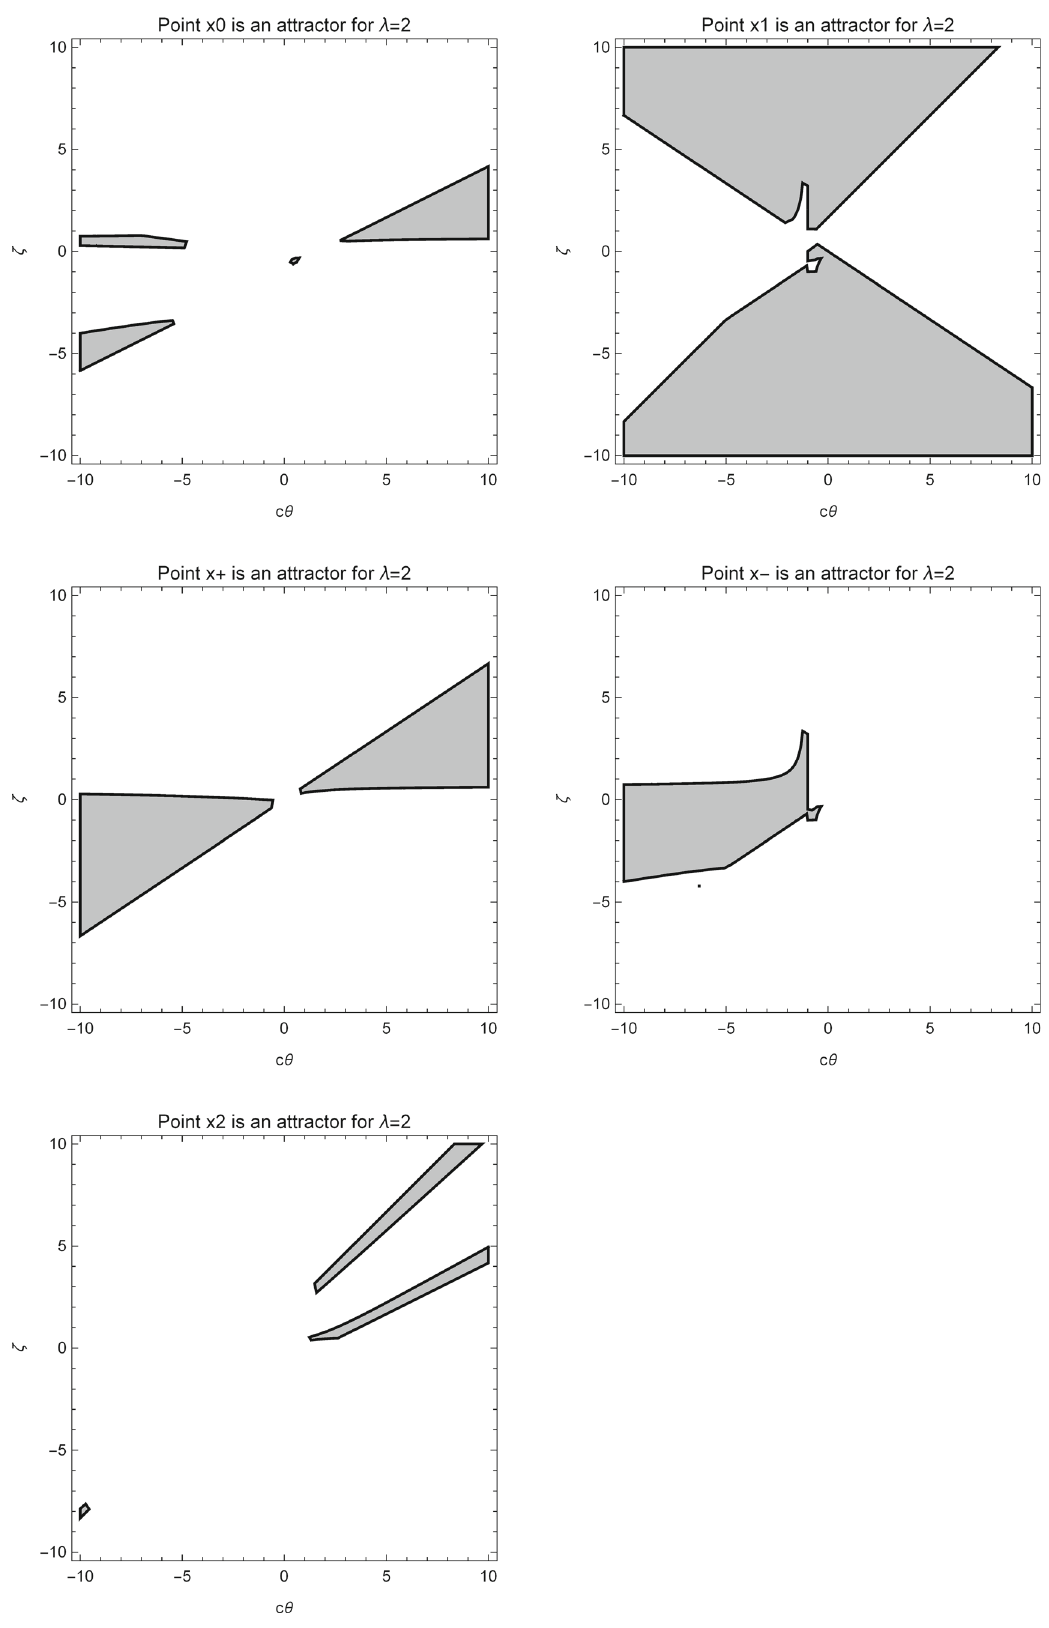
Fig. 7 Region plots in the space of parameters { c θ ,ζ } , where the stationary points x 0 , x ± , x 1 and x 2 are attractors, for λ =